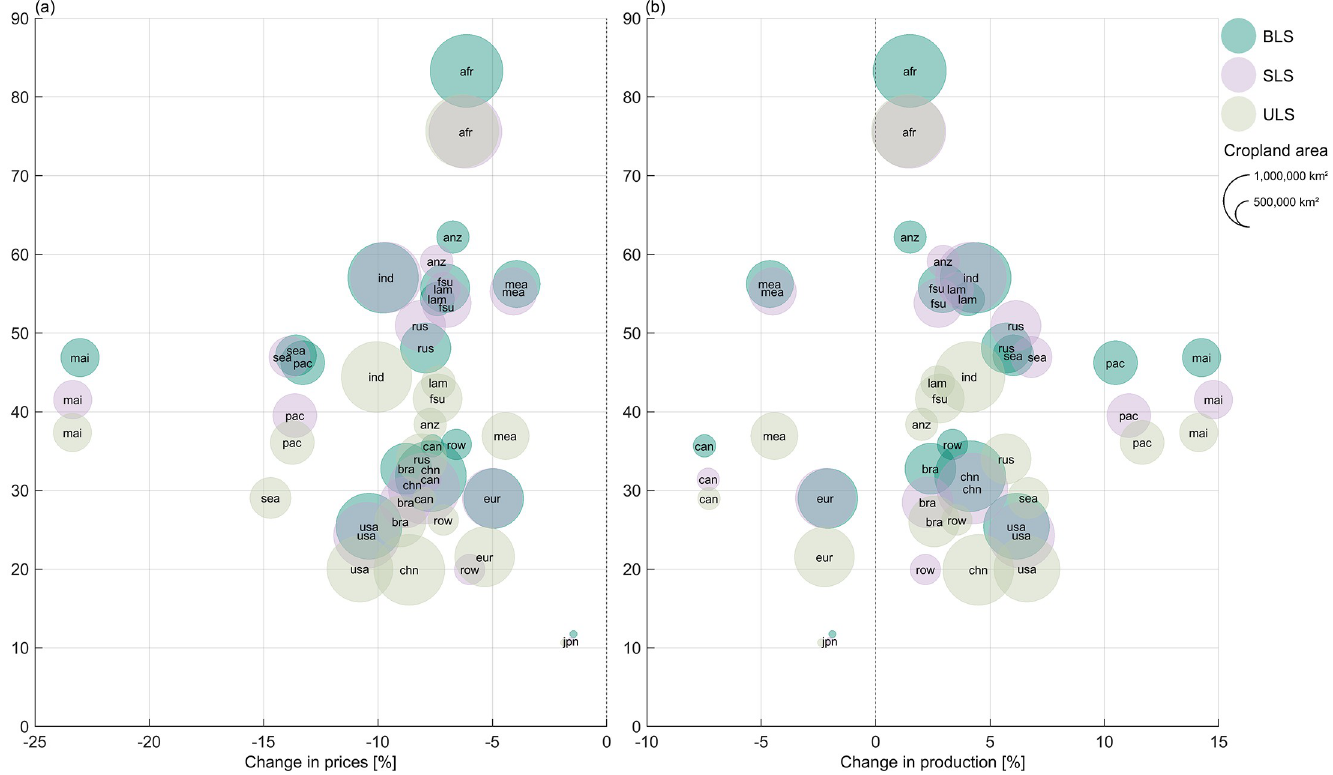
Fig 4. Land saving potentials and their resulting changes in production (a) and prices (b) aggregated over all crop categories for each region. The sizes of the dots reflect current statistical cropland area over all considered crop categories, while the colors of the dots display the different land saving strategies biophysical land saving (BLS), socio-economic land saving (SLS) and uniform land saving (ULS). For the abbreviations and further information on the regions of the analysis, see S3 Appendix.